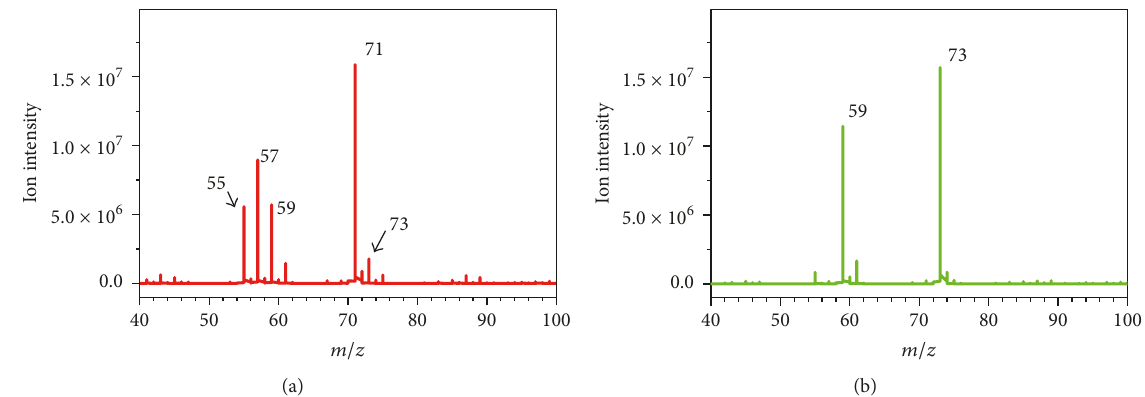
Figure 2: (a) Full scan mass spectra of four aldehyde mixtures with 0.5 𝜇 g/L for acrolein, propionaldehyde, crotonaldehyde, and butyraldehyde, respectively. (b) Full scan mass spectra of two ketone mixtures with 0.5 𝜇 g/L for acetone and butanone,